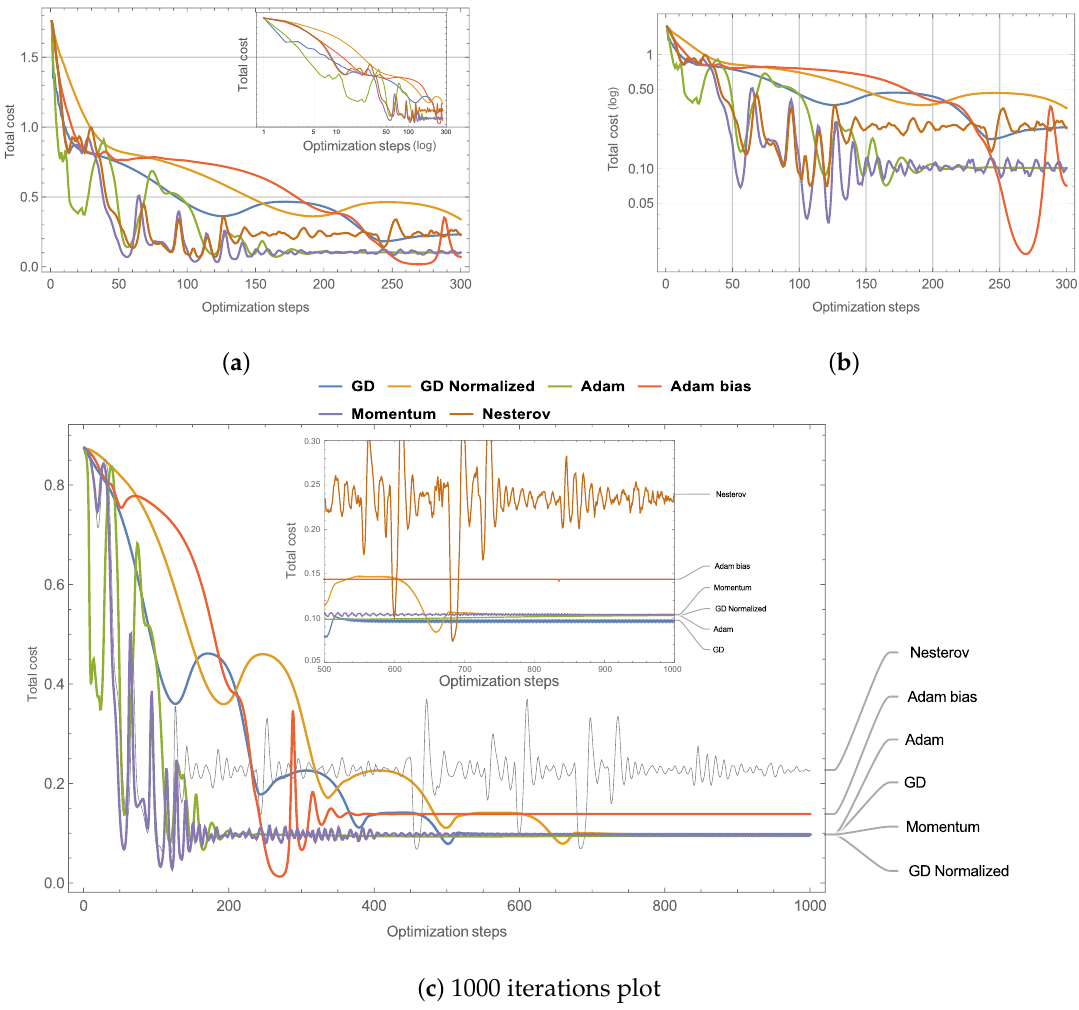
Figure 1. Panel ( a ) The linear plots of the total cost (running cost + final cost) vs optimization steps, using different GD variants and T max = 0.80. The miniature is the log plot in the x-axis and shows a detailed view of the first steps. Panel ( b ) is the logarithmic plot on the y-axis. Panel ( c ) shows the optimization for 1000 steps. The miniature shows a detailed view of the last 500